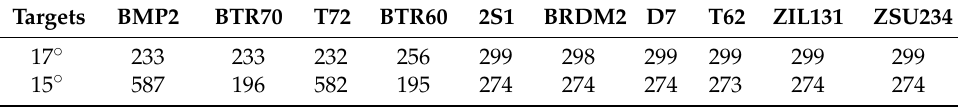
Table 1. The number of images of each object at different depression angles.